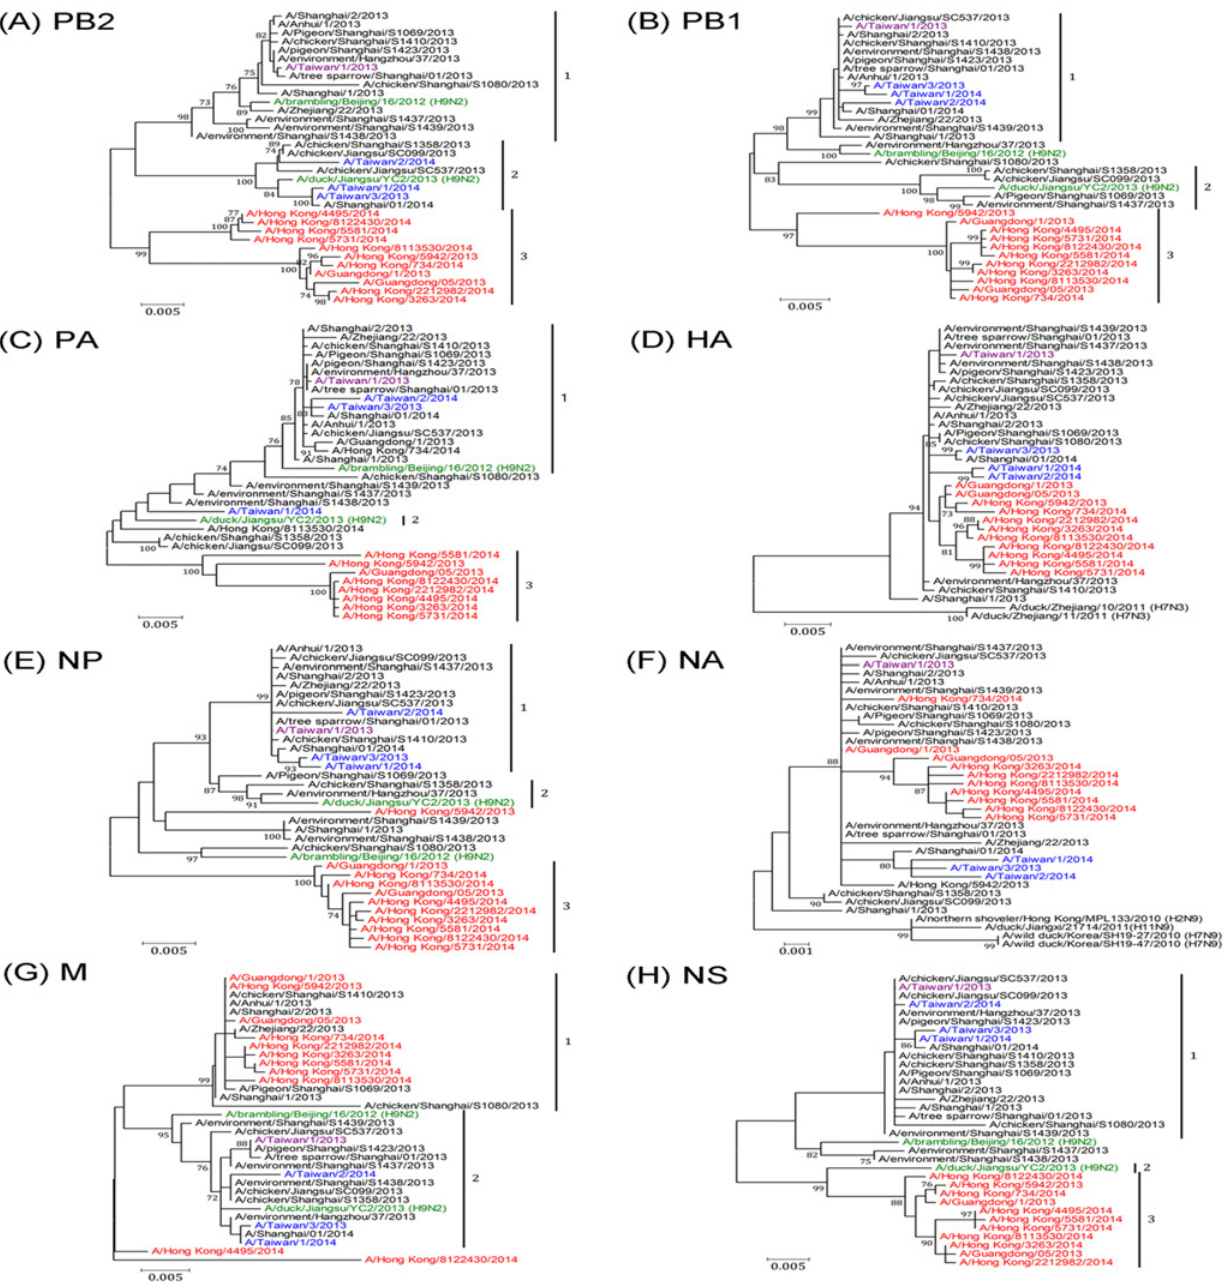
Fig 3. Phylogenetic relationships for (A) PB2, (B) PB1, (C) PA, (D) HA, (E) NP, (F) NA, (G) MP and (H) NS of the four imported H7N9 viruses identified in this study. The phylogenetic trees were constructed using the Maximum likelihood method with 1000 bootstrap replications. Branch values of more than 70 are indicated. Genome sequences of H7N9 viruses isolated from humans, poultry and the environment during the two epidemic waves in China were obtained from the NCBI and GISAID databases and were used as references. The classification of specific evolutionary clades, including the clades 1, 2 and 3, is indicated. The four imported viruses of Taiwan, which were isolated during the first or second waves of the H7N9 epidemic, were indicated by purple and blue colors, respectively. Viruses indicated by the green colors were the H9N2 lineages with genetic constellation related to the H7N9 viruses. Viruses indicated by the red colors were H7N9 strains isolated from Hong Kong and Guangdong in China during the second wave of the H7N9 epidemic.